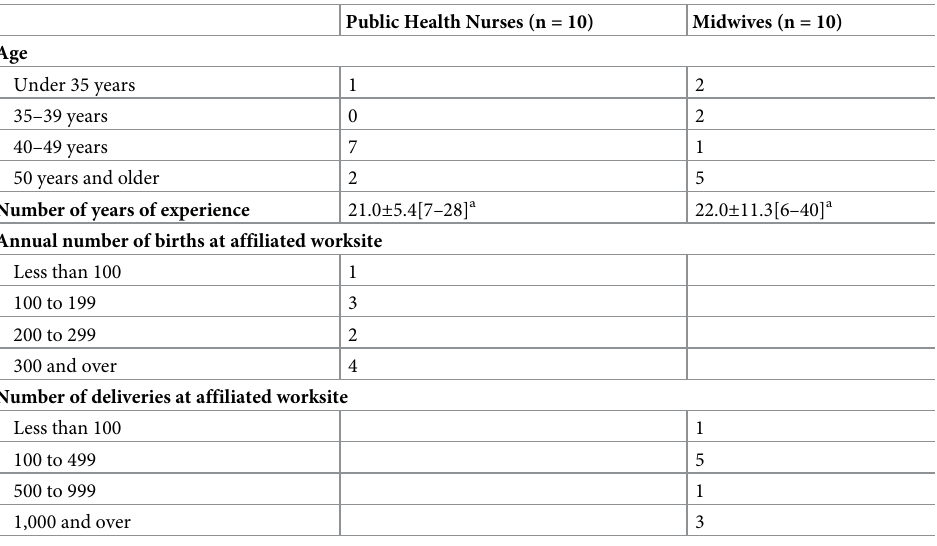
Table 1. Background of the